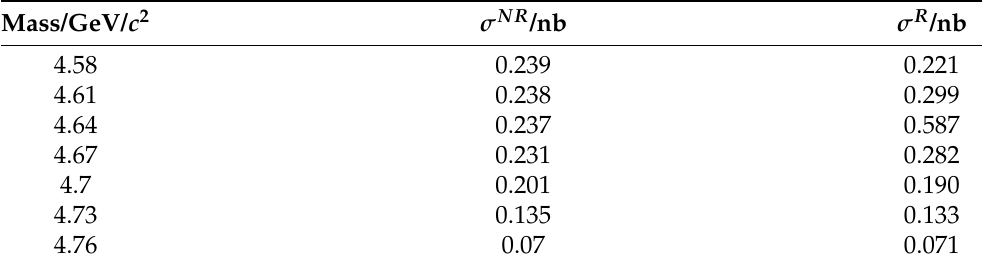
Figure 2. Fit to the available BESIII and Belle data close to the Λ + c ¯ Λ − c threshold, assuming the cross section has only non-resonant behavior. The red dots with error bars are the BESIII experimental data [11], the blue squares are the BELLE data [6], and the red line is the fit result with the formula on Equation (6) modified as described in the text. The first Belle data in Ref. [6] are not presented in the plot, as discussed in the introduction. Table 1. Summary table of the predicted cross sections in the case of only the non-resonant cross section ( σ NR ) and resonant one ( σ R